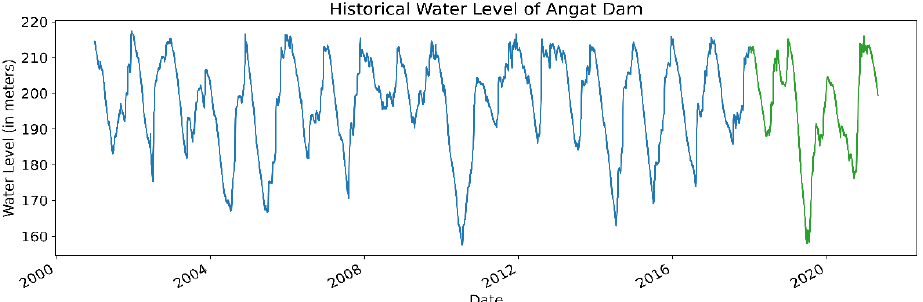
Figure 2. Historical water levels (above mean sea level) of the Angat Dam, from 1 January 2001 to 30 April 2021, in meters. The time series shows a drastic drop in 2019 (corresponding to the 2019 Metro Manila Water Crisis) that has only been seen on one other occasion, in 2010. Blue observations denote the training set and green observations denote the test set.